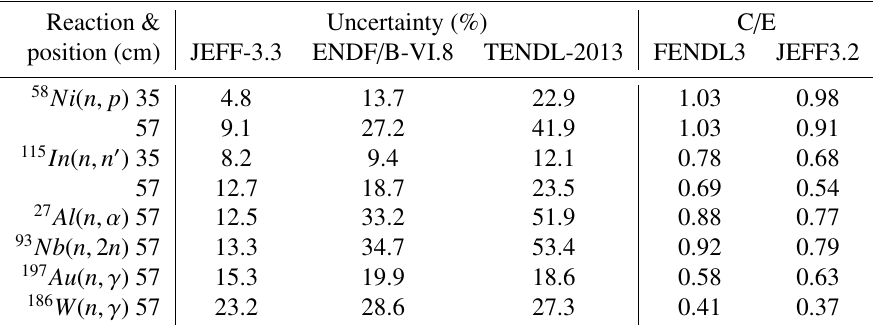
Table 1. FNG-Cu benchmark: Comparison of the C / E values and the computational uncertainty due to transport cross-sections using di ff erent nuclear data